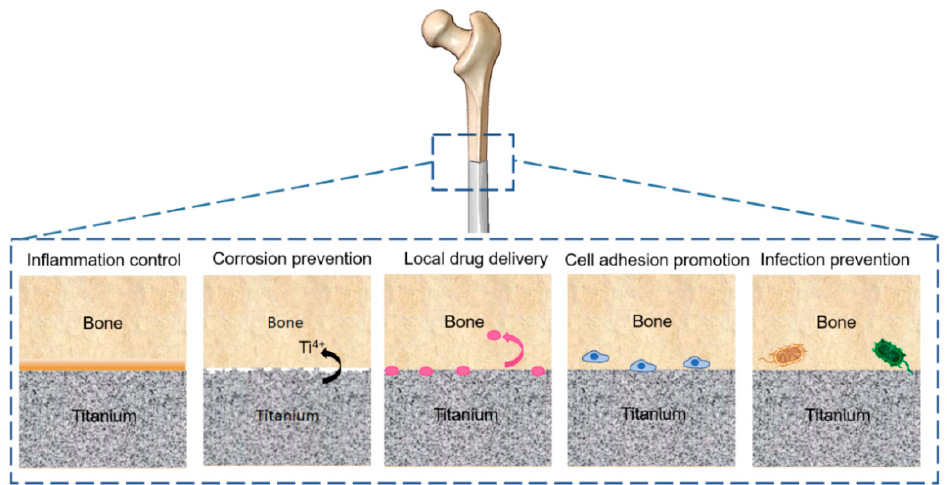
Figure 2. Schematic representation of phenomena occurring at titanium implant-bone interfaces.